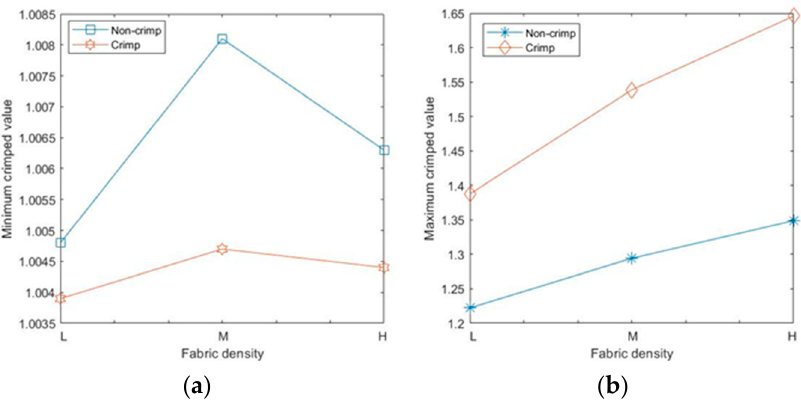
Figure 10. Fibre crimp results: ( a ) minimum values and ( b ) maximum values. Table 4. Average statistical values of X-ray µCT models.